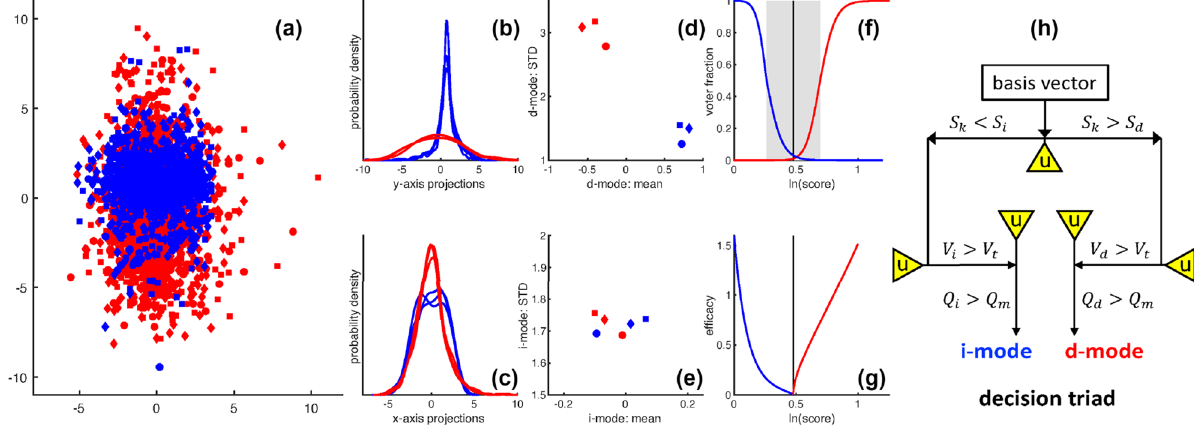
Figure 2. Key aspects of SPLOC-RNN. (a) Example scattered data in a plane for six data streams. (b) Along the y-axis, data packets separate into two distinct classes. (c) Along the x-axis, all six data packets share similar emergent properties. These observations follow from the probability densities for scattered data projections. (d) A mode feature space plane (MFSP) plots the mean and standard deviation (STD) of the probability density along the y-axis for a discriminant-mode (d-mode). (e) The MFSP is shown for the probability density along the x-axis for an indifferent-mode (i-mode). (f) Voting activation functions for an i-mode (blue) and d-mode (red) are shown. The re-entrant behavior at the 50% levels bound the indecision region (gray area) due to uncertainty in discerning differences or similarities between systems. (g) The rectifying adaptive nonlinear unit is shown when d-mode (red) and i-mode (blue) functions have MFSP clustering quality factors set to unity. The bifurcation line is shown as a vertical black line in panels (f,g) . (h) Flow chart for mode selection. The decision triad stratifies the complete set of basis vectors into discriminant, undetermined and indifferent modes. Discriminant and indifferent modes respectively quantify differences and similarities in features when signal-to- noise, statistical significance and quality of clustering all surpass minimum thresholds, otherwise the projection is an undetermined-mode, denoted by yellow